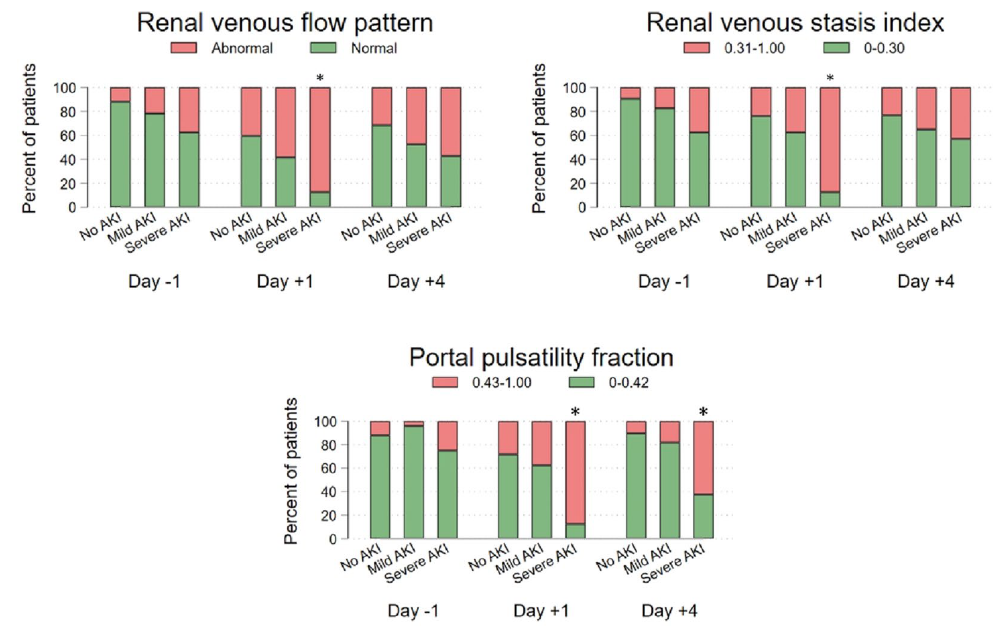
Figure 2. Distribution of patients within each of the venous ultrasound measurements in per cent according to different time points. Patients were divided according to the degree of AKI. Day − 1, + 1 and + 4 refer to the day before surgery, the first postoperative day and the fourth postoperative day. No AKI, mild AKI and severe AKI refer to patients who did not develop AKI, developed mild AKI (KDIGO grade 1) or developed severe AKI (KDIGO grades 2 + 3) within the first four postoperative days. *indicates statistically significant difference (P < 0.05) when comparing patients with no AKI and patients with either mild or severe AKI. See Table s1, supplementary material for exact values. AKI acute kidney injury, KDIGO kidney disease improving global outcomes.